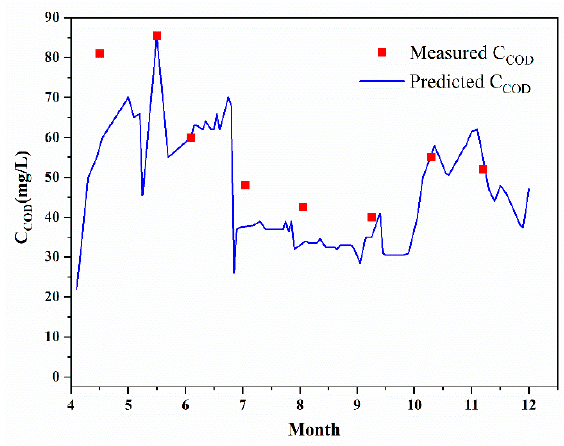
Figure 5. Simulated results of the COD concentration in 2010.